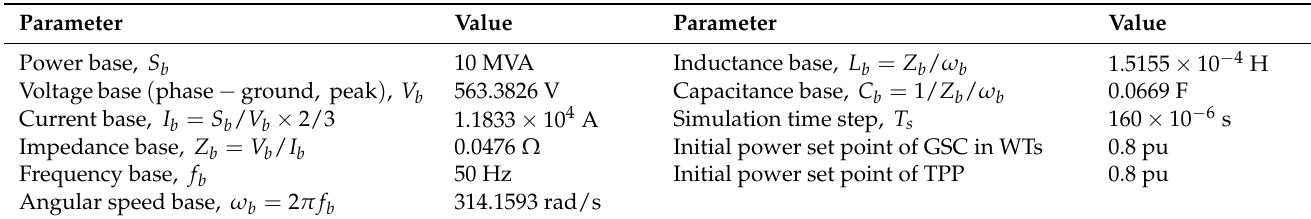
Table A5. Per unit representation and simulation settings.